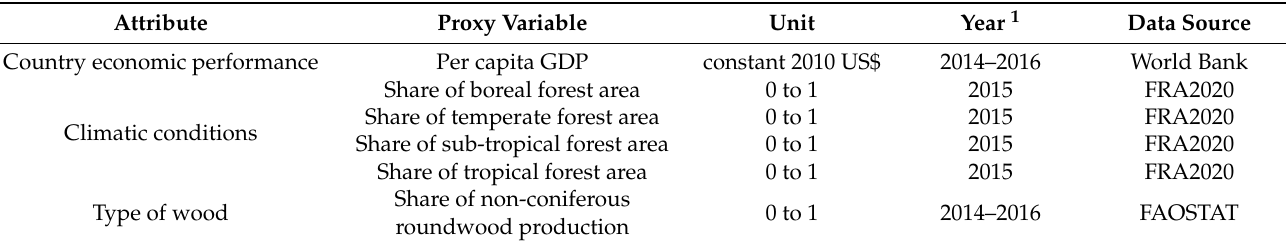
Table 2. Attribute variables used in the cluster